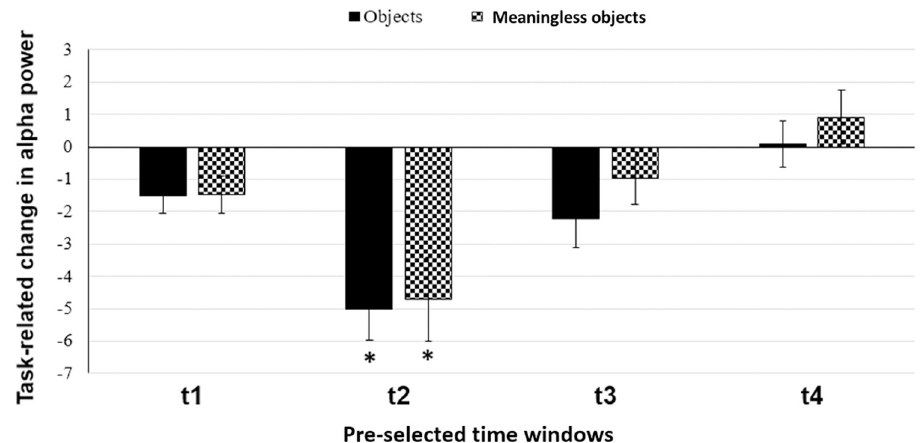
Fig 3. Task-related change in alpha band power averaged over four electrodes of interest (TP7, TP8, P7, P8) and plotted for different time windows. Solid black bars represent object stimuli; checked bars represent meaningless object stimuli. t1 = 0–500 ms; t2 = 250–750 ms; t3 = 500–1000 ms; t4 = 750–1250 ms. Error bars are SEM. Asterisks indicate p <